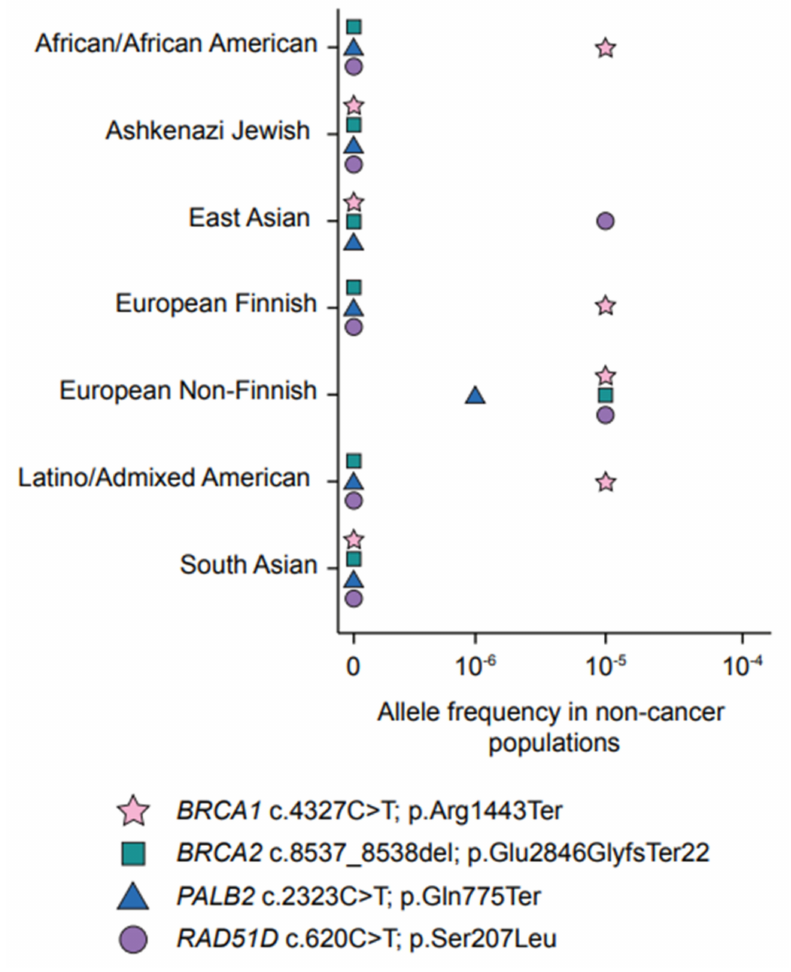
Figure 2. The most frequently occurring pathogenic variants BRCA1 , BRCA2 , PALB2 , and RAD51D in French Canadians of Quebec and their allele frequency in other worldwide non-cancer